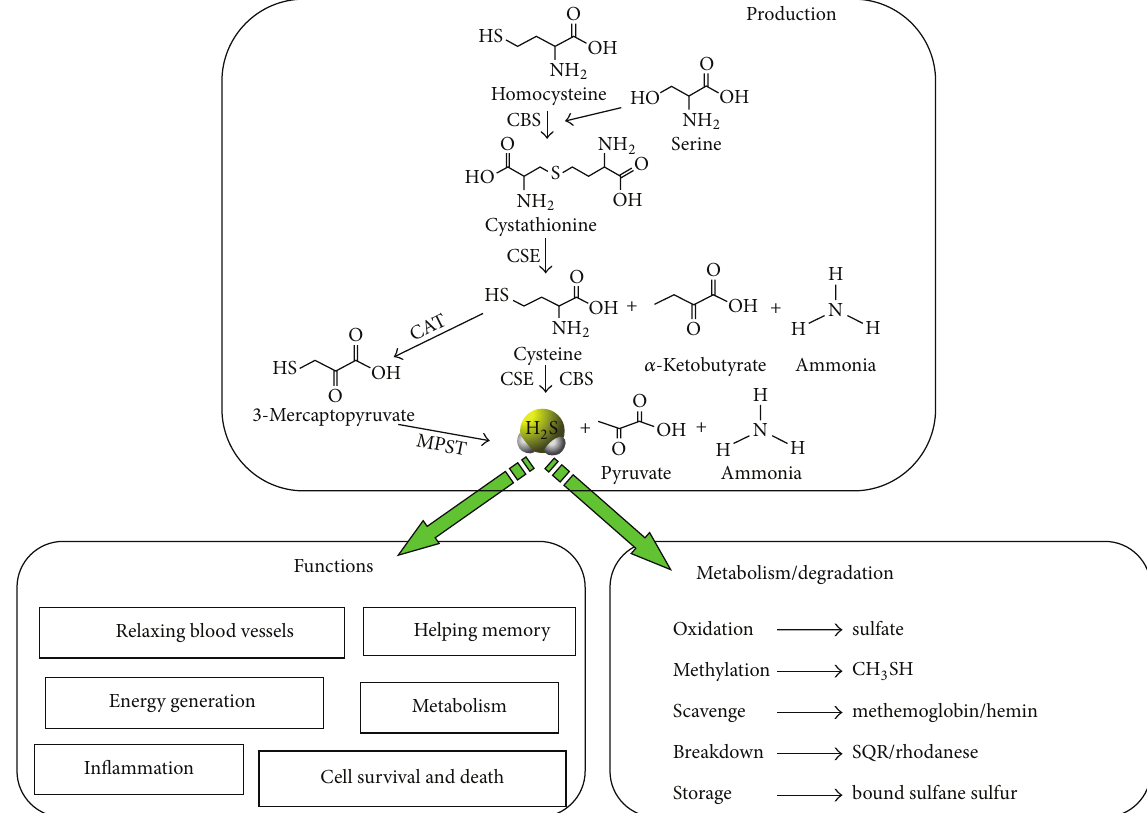
Figure 1: H 2 S biosynthesis, functions, and metabolism. So let us first look at how H 2 S is endogenously produced. In mammalian cells, H 2 S can be endogenously produced through the transsulfuration pathway. With cysteine as the main substrate, CBS or CSE, which we called cystathionine gamma-lyase or cystathionine beta-synthase, can catalyze cysteine into H 2 S and other products. The expression of CBS and CSE is tissue-specific, CBS is mostly expressed in brain, and CSE is in the cardiovascular system and other big tissues, such as liver and kidney. The half-life of H 2 S inside the cells is very fast; it is estimated in several seconds and can be quickly oxidized, scavenged, or broken down by different ways. Now it has been widely recognized that H 2 S plays very important physiological role in the whole body and also cells; for example, it can relax blood vessel and acts as an endothelial deprived hyperpolarizing factor, can enhance long term potentiation and help memory, and can control energy generation and regulate metabolism, inflammation; more importantly, H 2 S is required for cell fate decision; that is the topic we are going to talk about in the